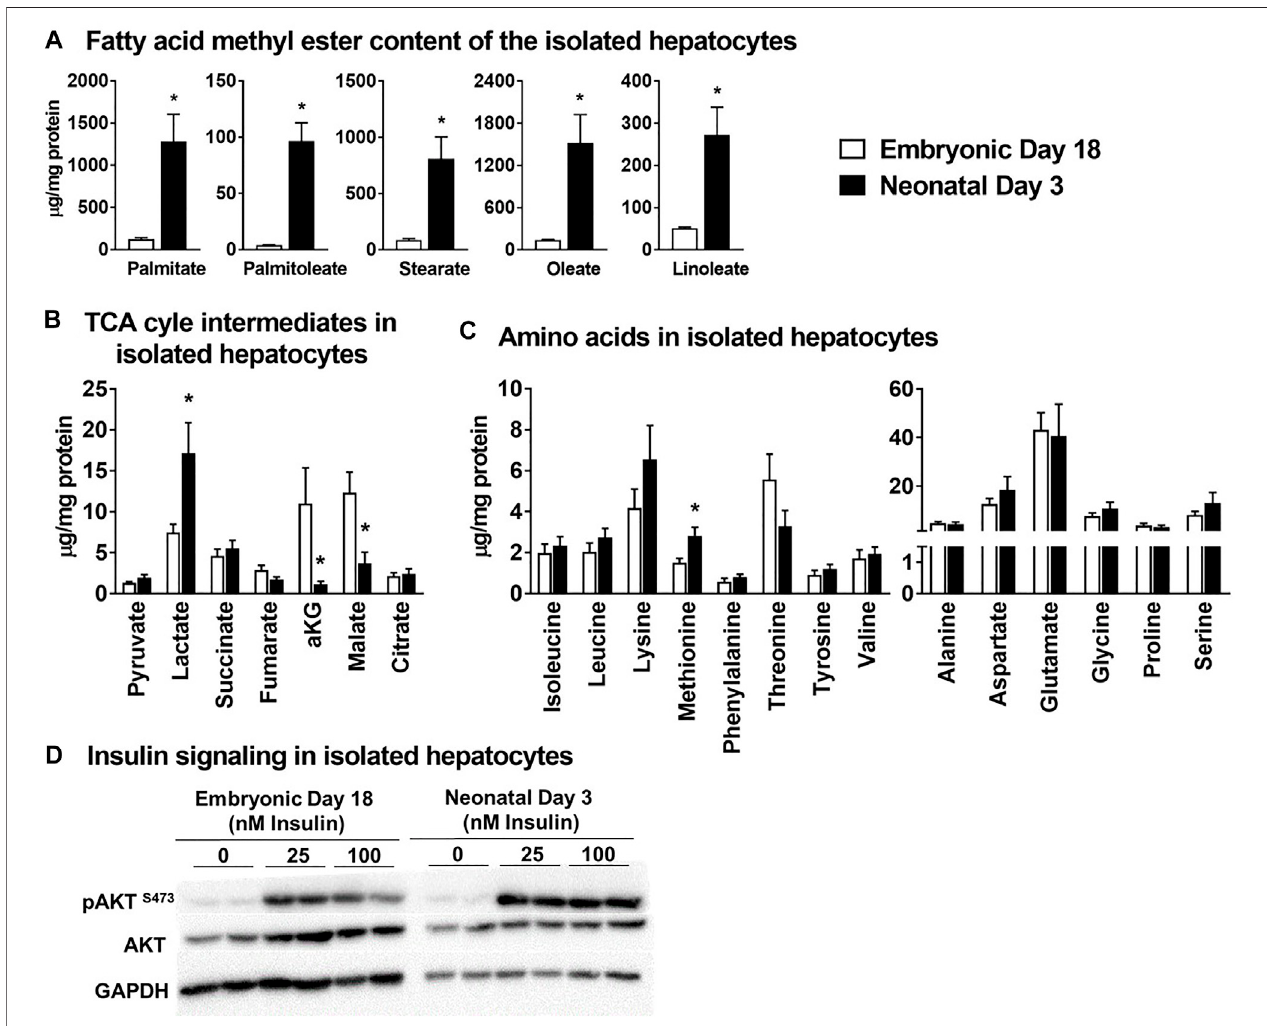
FIGURE 4 | Primary isolated hepatocytes from broiler chicken embryos and neonates - a metabolic model to investigate mitochondrial metabolism and lipid accumulation. All metabolite concentrations were normalized to the cell protein content of the isolated hepatocytes. (A) Concentrations of triglyceride derived fatty acid methyl esters in the hepatocytes, (B) Levels of TCA cycle intermediates in the isolated hepatocytes (C) levels of essential and non-essential amino acids in the isolated hepatocytes and, (D) western blot analysis of pAKT at Ser-473 as an index of insulin signaling. All the values are represented as means ± SEM with n = 4 – 6 independent replicates/group. Each replicate consisted of pooled hepatocytes isolated from 2 – 3 birds. Results were considered signi fi cant at p ≤ 0.05 (*) following a Student t -test between embryonic day 18 and neonatal day 3. AKT, Protein kinase B.